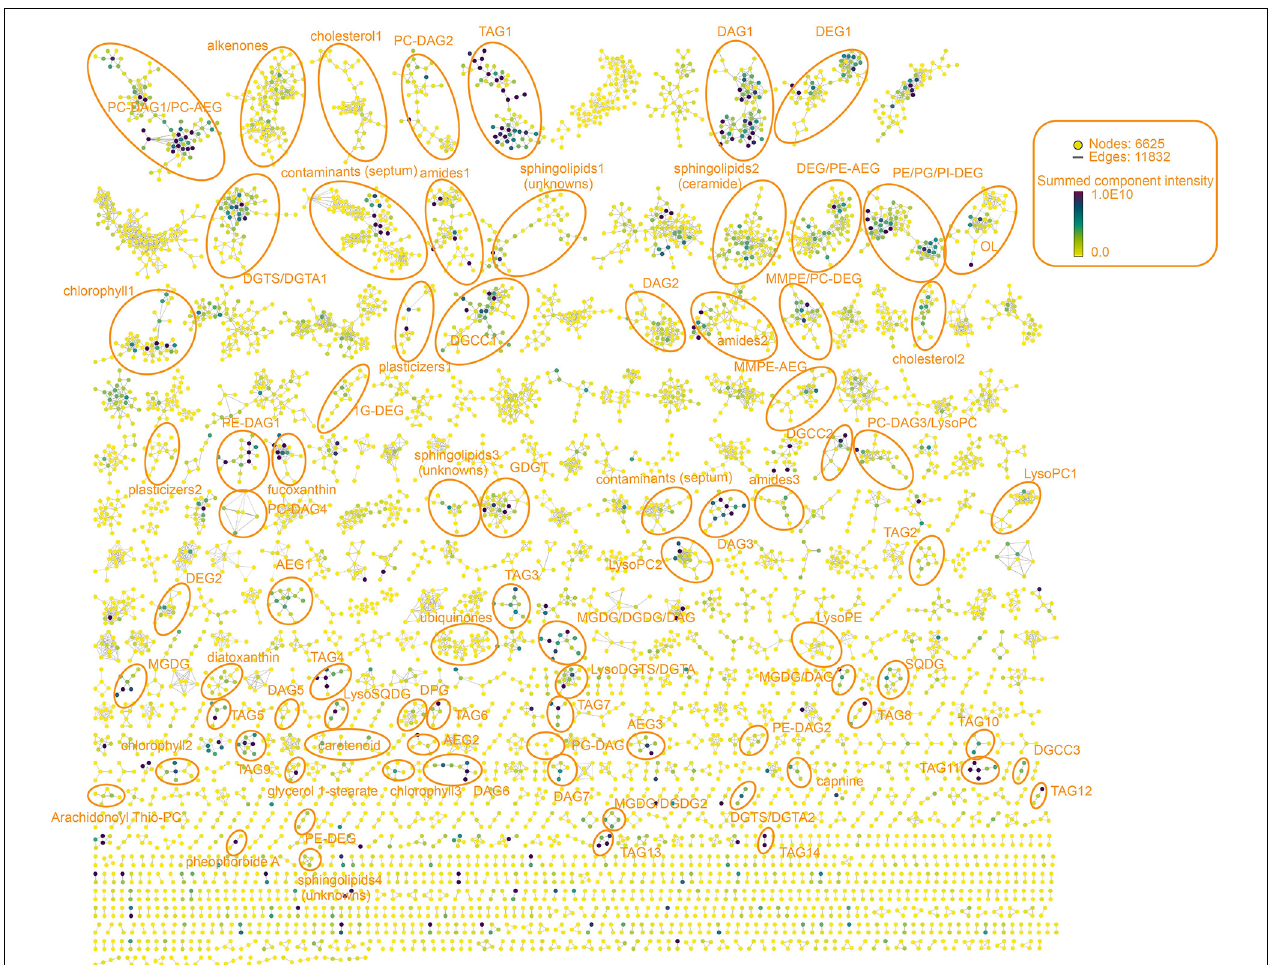
FIGURE 2 | Molecular network of the water column in the Black Sea. Nodes represent MS/MS spectra of ion components (lipids) which are connected based on spectral similarity (cosine > 0.6). Nodes are labeled from light yellow to dark blue with the increasing of the summed intensity among all the water column samples (15 depths). The spatial orientation of the nodes in the MS/MS network ( Figure 2 ) is randomly generated by Cytoscape (Shannon et al., 2003; Smoot et al., 2010) and does not relate to relationships between the subnetworks. Lipid classes (clusters) with the annotation are either tentatively identified in this study or have been reported by the previous studies (Schubotz et al., 2009, 2018; Van Mooy and Fredricks, 2010; Danielewicz et al., 2011; Wakeham et al., 2012; Bale et al., 2016; Kharbush et al., 2016; Becker et al., 2018b). DAG, diacylglycerol; DEG, dietherglycerol; AEG, acyletherglycerol; TAG, triacylglycerol; DGTS, diacylglycerylhydroxymethyltrimethyl-(N,N,N)-homoserine; DGCC, diacylglycerylcarboxyhydroxymethylcholine; DGTA, diacylglyceryl-hydroxymethyl)-tri-methyl-b-alanine; OL, ornithine lipid; DPG, diphosphatidylglycerol; PC, phosphatidylcholine; PE, phosphatidylethanolamine; PG, phosphatidylglycerol; PI, phosphatidylinositol; MMPE, phosphatidyl-(N)-methylethanolamine; MGDG, monoglycosyldiacylglycerol; GDGT, glycerol dialkyl glycerol tetraethers; SM, sphingomyelin; SQDG, sulfoquinovosyl